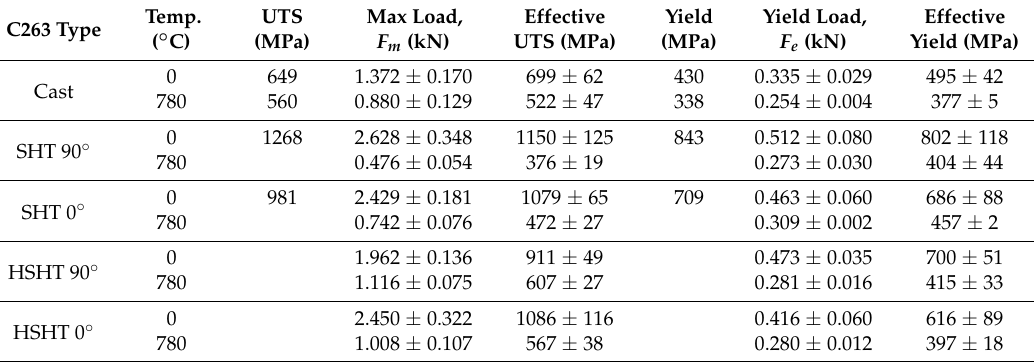
Table 2. Summary of C263 data for SPT and uniaxial test types for both RT and 780 ◦